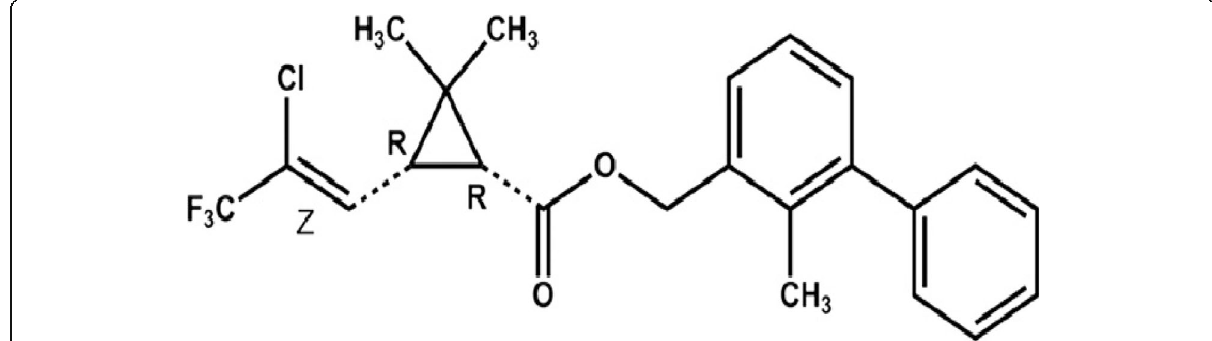
Fig. 1 Structure of bifenthrin